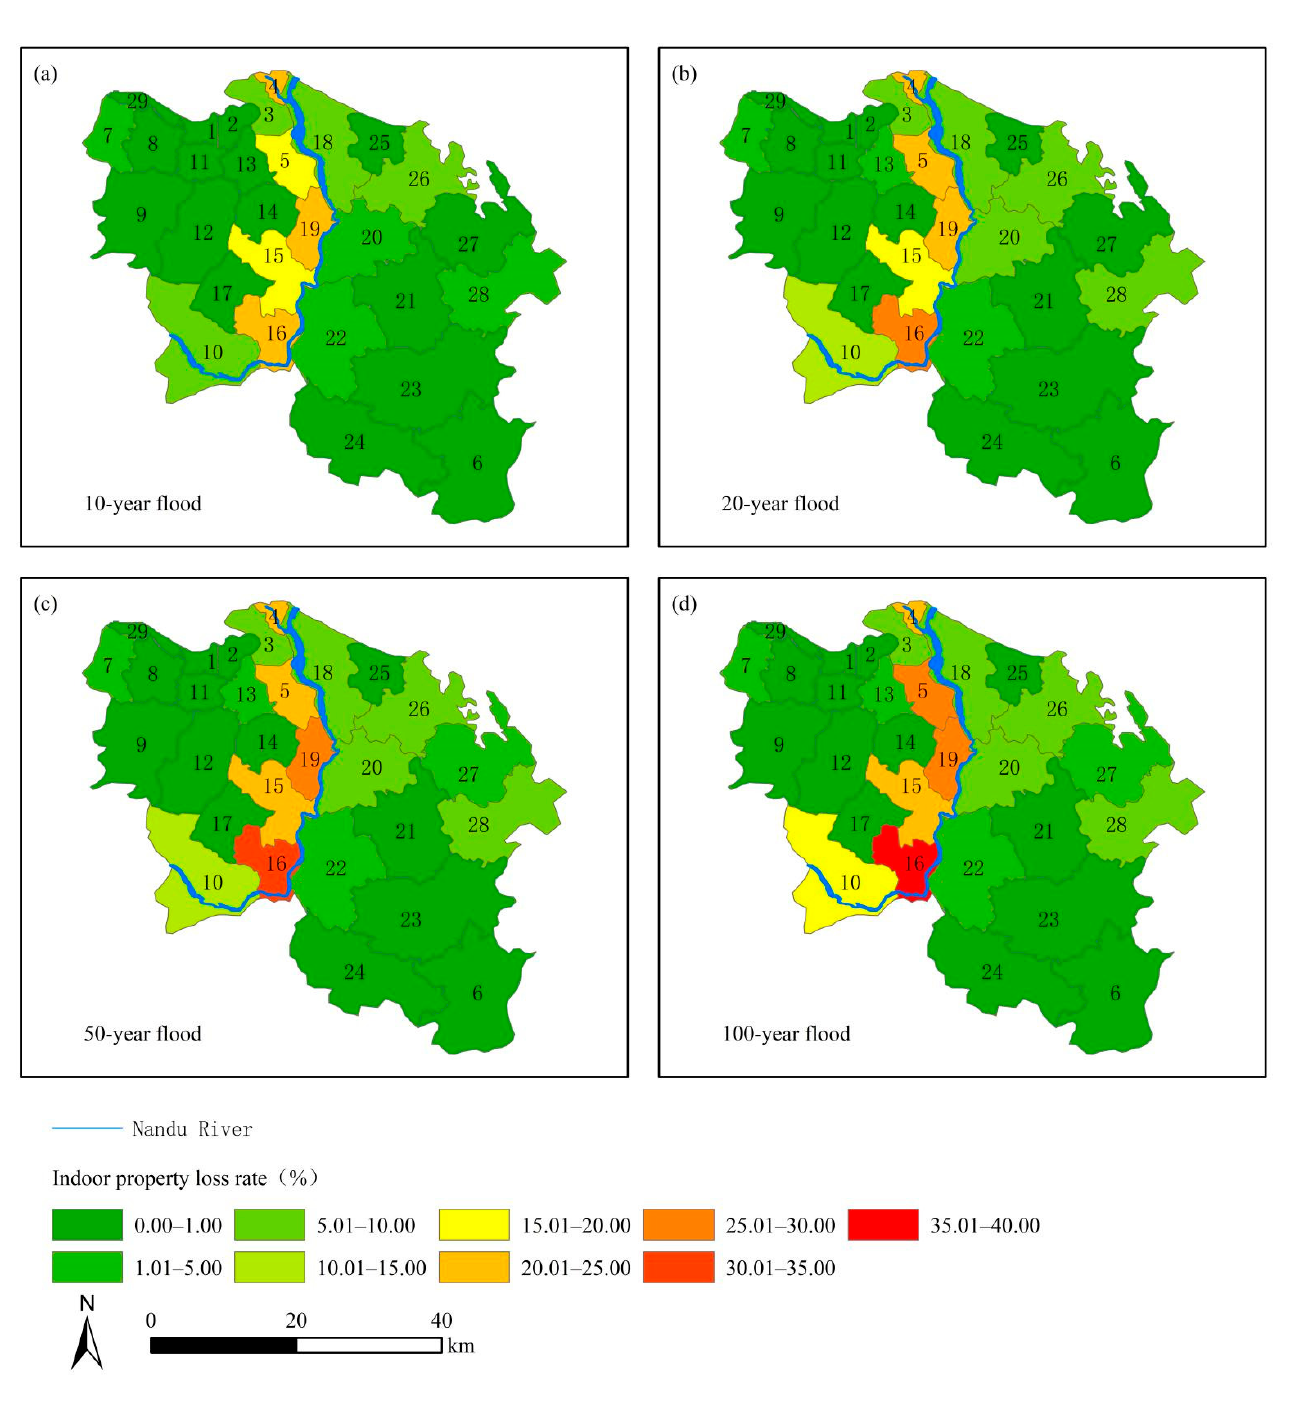
Figure 4. Indoor property loss rate in different flood return periods in Haikou City. ( a ) 10-year, ( b ) 20-year, ( c ) 50-year, ( d ) 100-year. Note: The numbers represent assessment units.